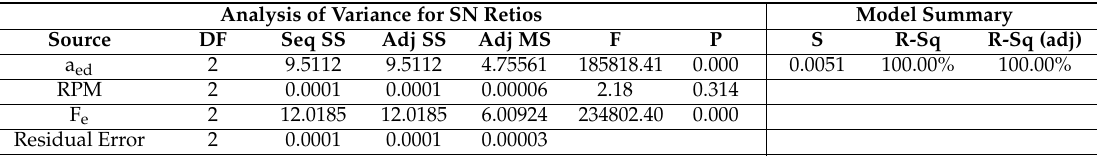
Table 7. The ANOVA values for S/N ratios.